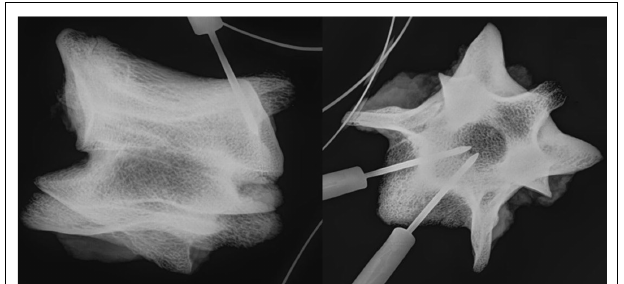
FIGURE 1 | Radiograph showing the location of the temperature probes within the vertebra in a lateral (left) and axial (right) view .